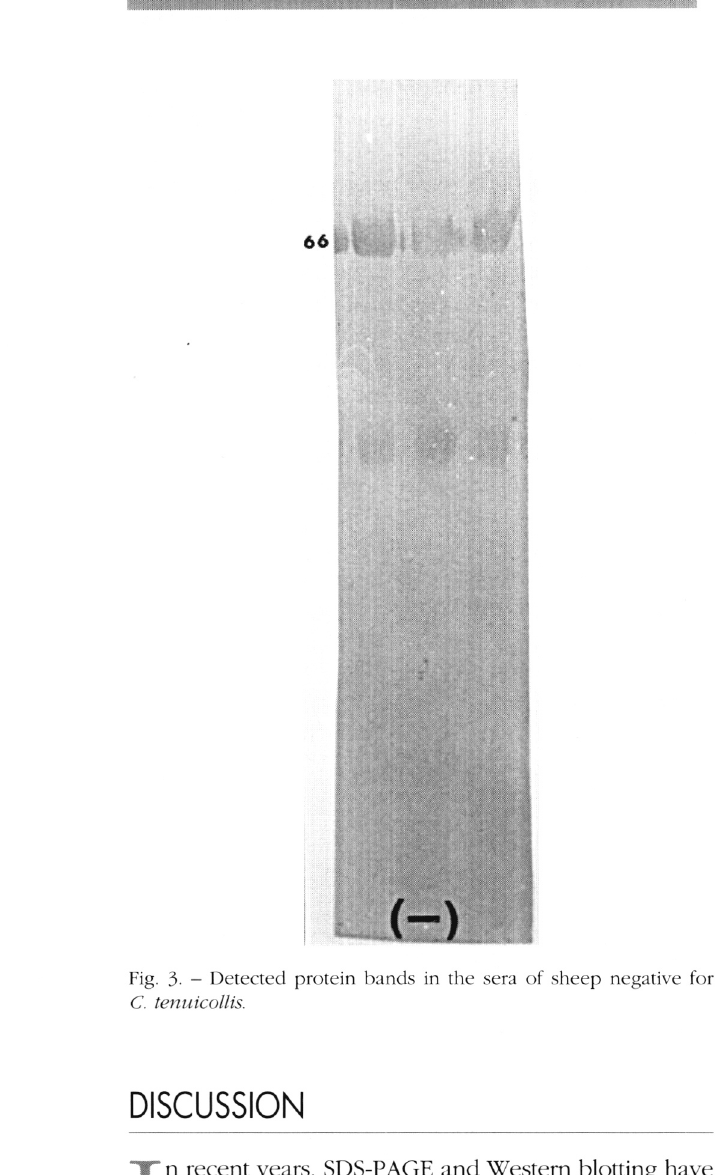
Fig. 3. - Detected protein bands in the sera of sheep negative for C.